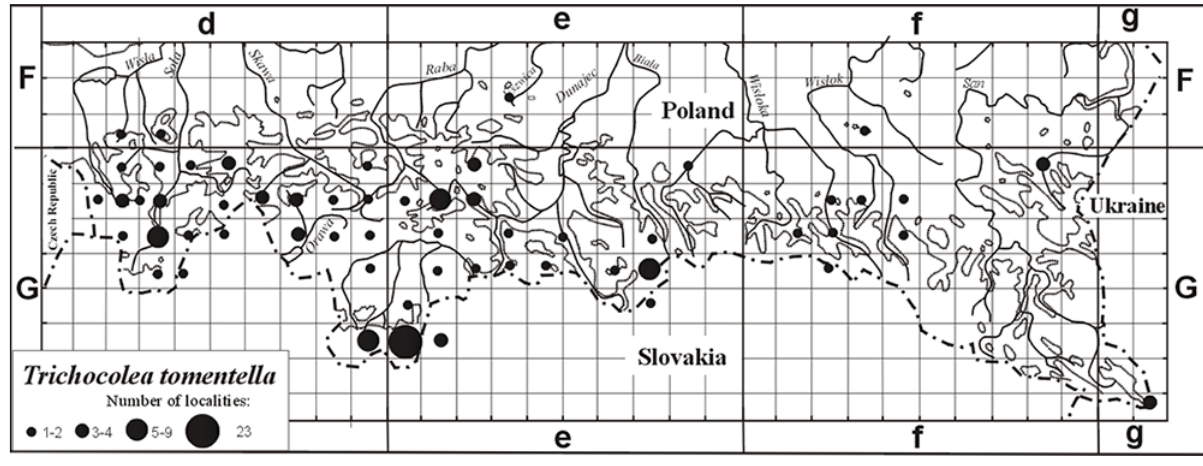
Fig. 1 Geographical distribution of Trichocolea tomentella in the Polish part of the Carpathians.